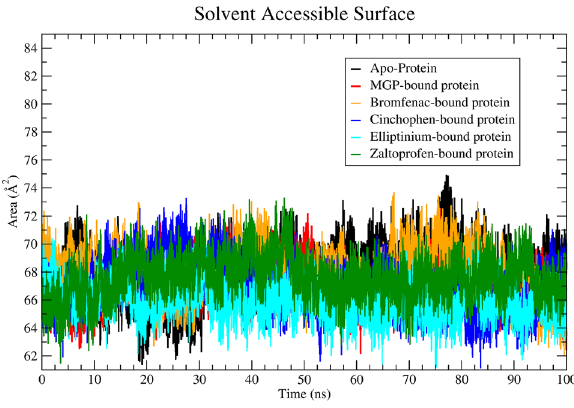
Figure 5. The solvent-accessible surface area (SASA)-versus-time